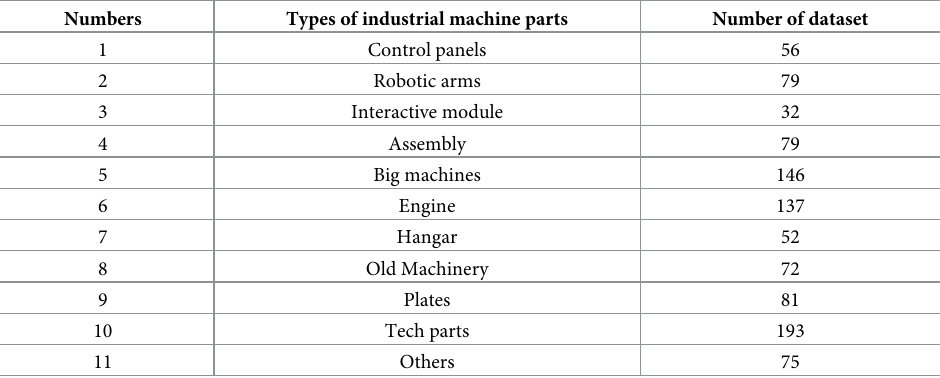
Table 1. Summary of the number of each category.